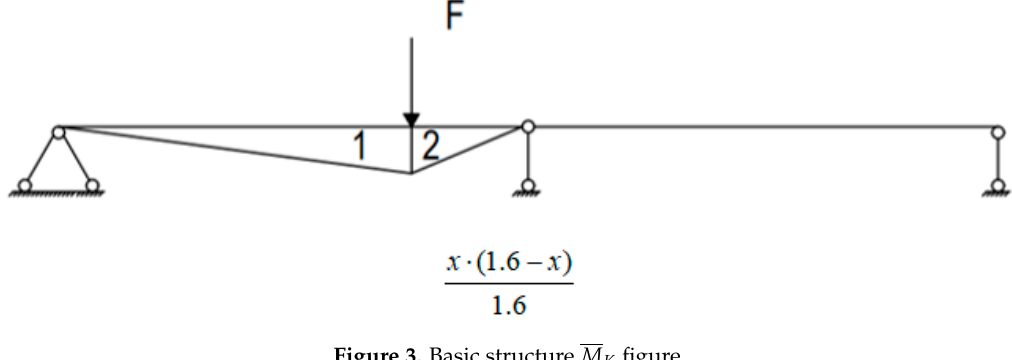
Figure 3. Basic structure figure.